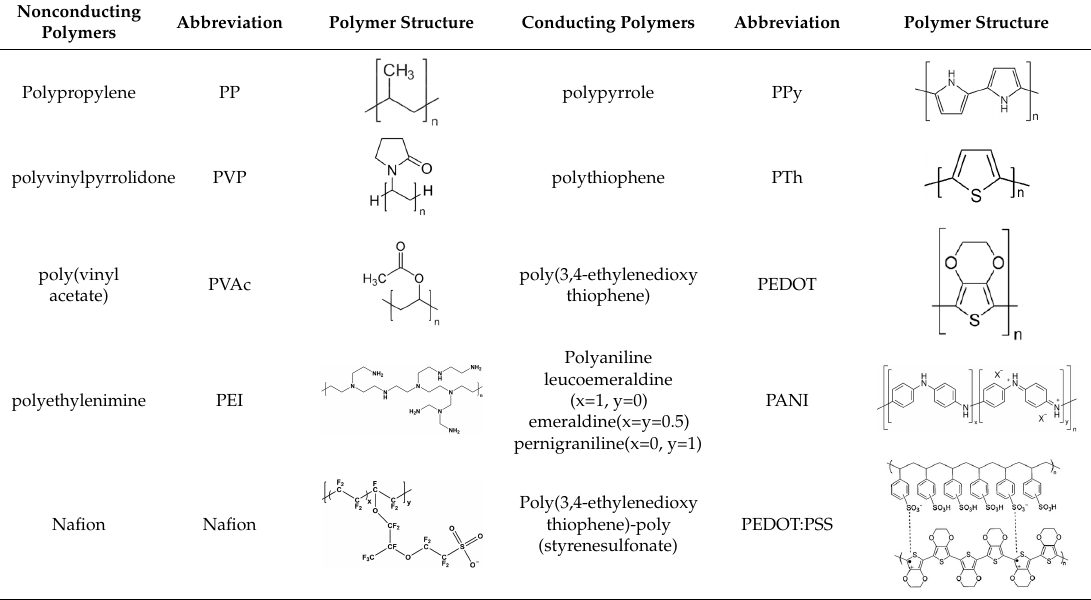
Table 1. The chemical structure of polymers used to prepare thermoelectric materials.